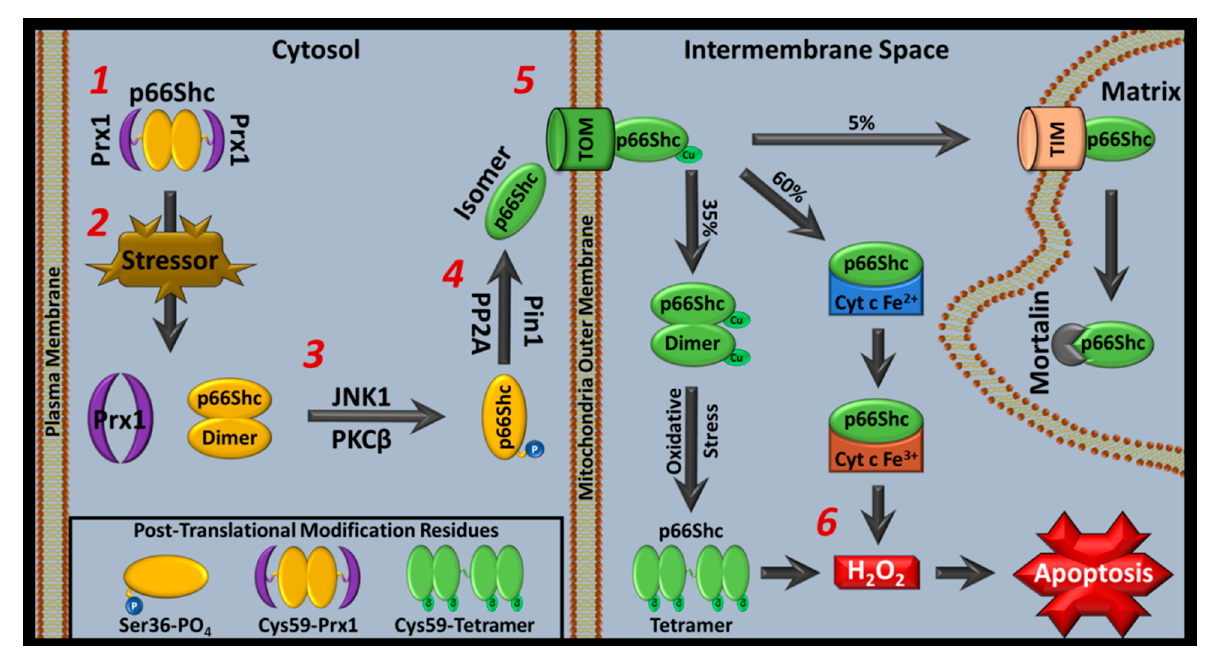
Figure 3. Classical p66Shc mitochondrial ROS activity pathway. (1) Until stressors are present, p66Shc remains inactive via Prx1-mediated cytosol sequestration. (2) Once stressed, Prx1 releases p66Shc as a dimer. (3) Free p66Shc dimers are phosphorylated by JNK1 or PKC β , resulting in phosphorylated p66Shc monomers. (4) p66Shc monomers are isomerized and dephosphorylated via Pin1 and PP2a, respectively. (5) p66Shc isomers are granted IMS access via TOM interactions that cause copper to associate with p66Shc. (6) p66Shc oxidizes cyt c to produce H 2 O 2 . Oligomerization status is unclear during ROS generation, but purified mouse CH2 experiments and mouse embryonic fibroblast studies implicate monomers, dimers, and tetramers.